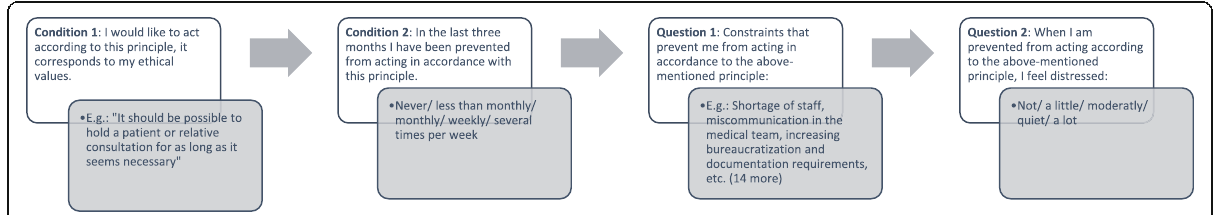
Fig. 1 Structure of the questionnaire demonstrated by exemplary use of item 1